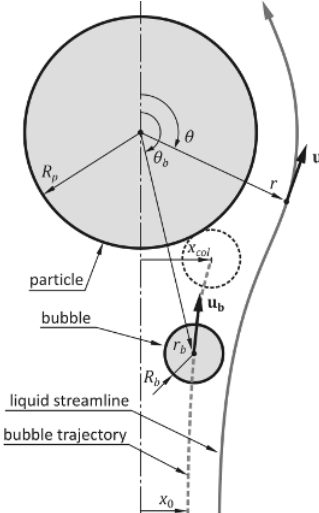
Fig. 1. Studied configuration and